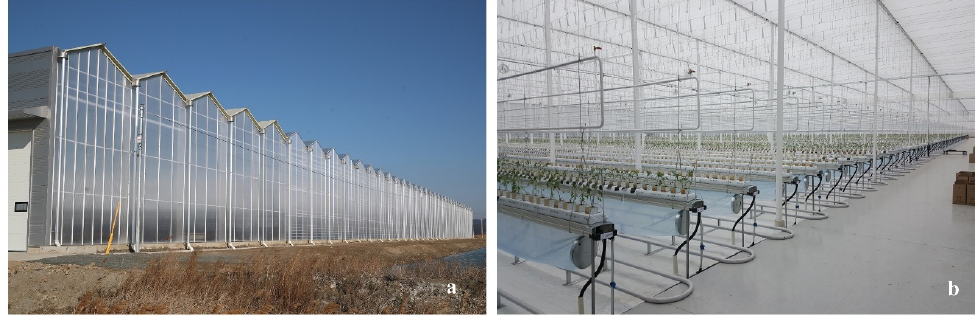
Figure 2. Experimental greenhouse at Taean Gun (latitude 36.88° N, longitude 126.24° E): ( a ) exterior view and ( b ) interior view.